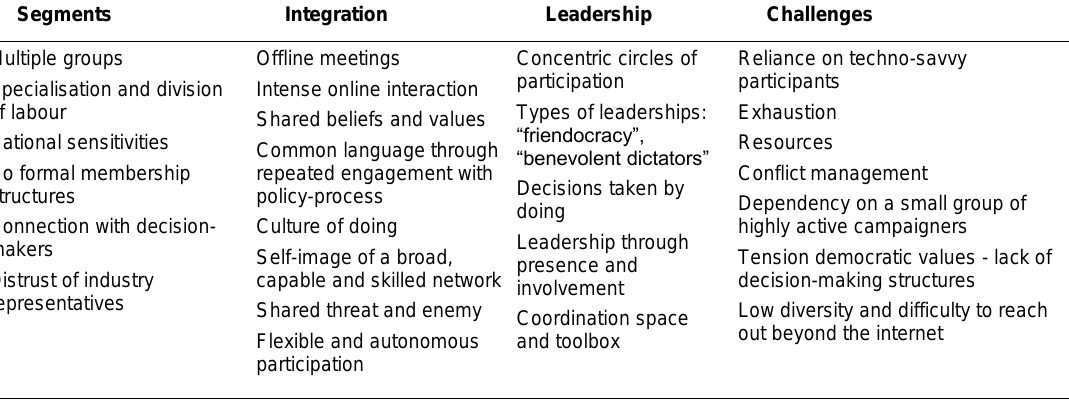
Table 1: Summary of key